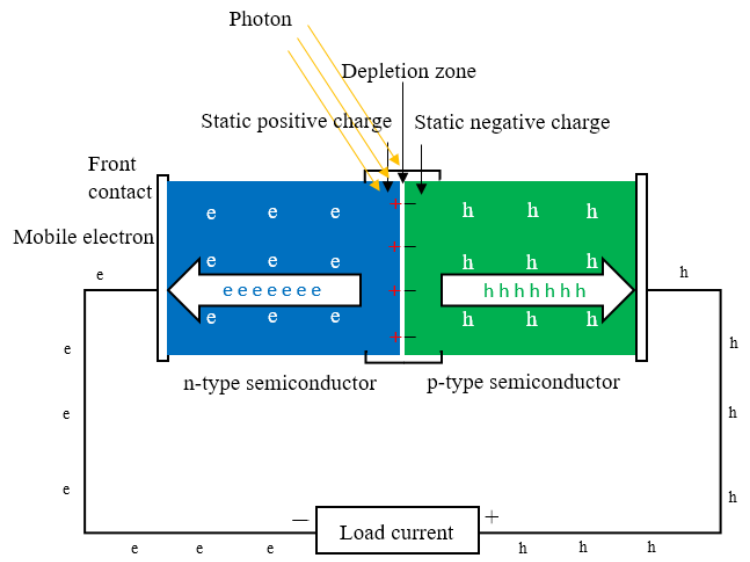
Figure 1 . Principle of photovoltaic effect for a photon to electrical energy conversion (e: electron, and h: hole) [31]